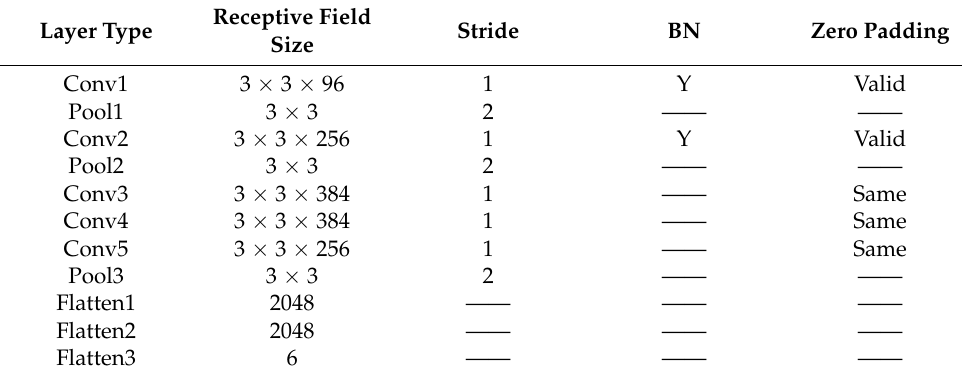
Table 3. Adap–Alex structure parameter setting.